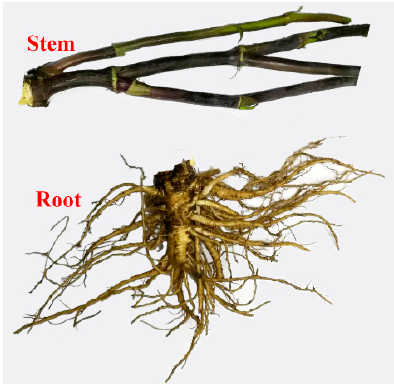
Figure 1. Photographs of Angelica sinensis stem and root.